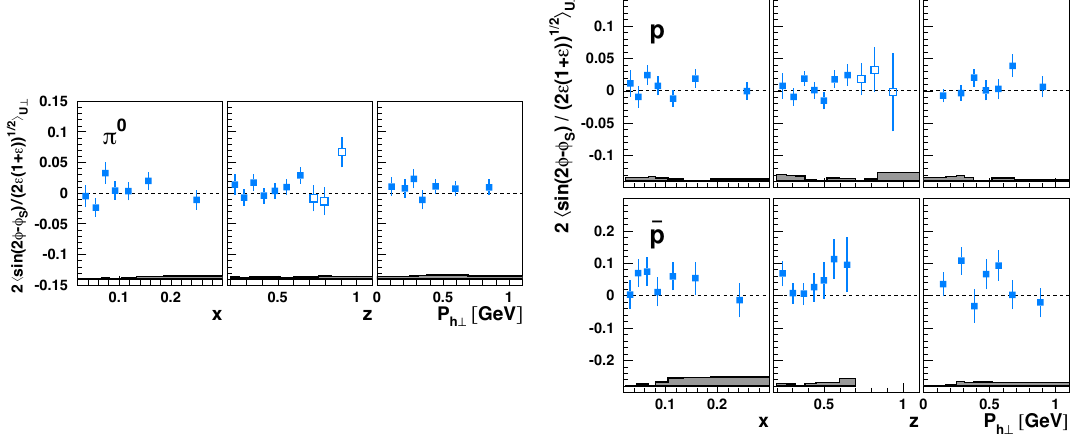
p Figure 24 . The 2 h sin(2 φ − φ S ) / 2 (cid:15) (1+ (cid:15) ) i h amplitudes for π 0 (left), protons, and antiprotons U ⊥ (right) presented either in bins of x , z , or P h ⊥ . Data at large values of z , marked by open points in the z projection, are not included in the other projections (no such high- z points are available for an- tiprotons due to a lack of precision). Systematic uncertainties are given as bands, not including the additional scale uncertainty of 7.3% due to the precision of the target-polarization